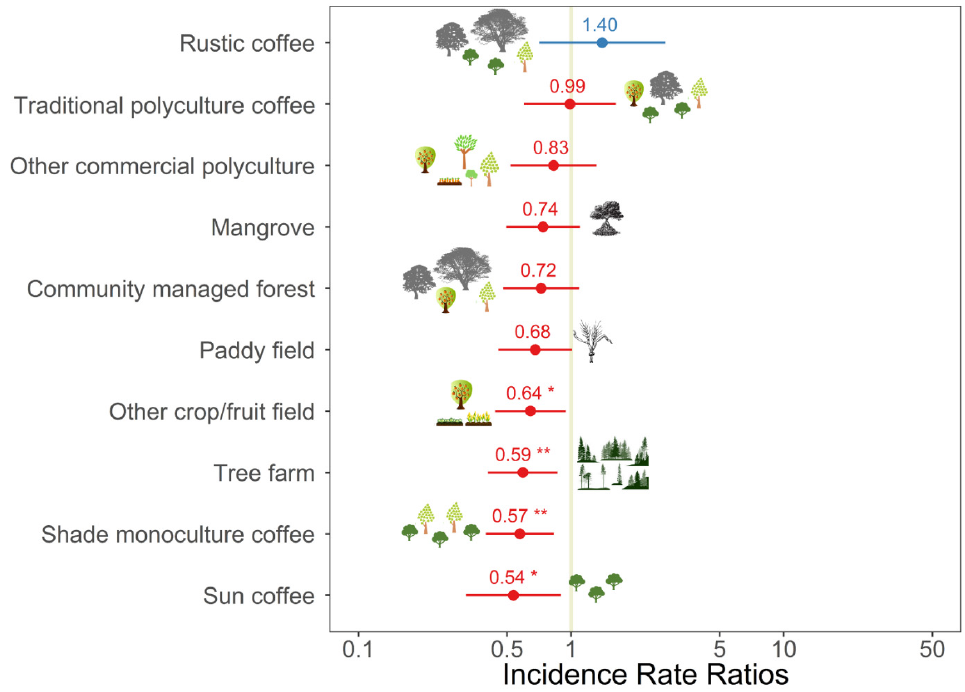
Figure 3. Incidence rate ratios between the diversity of birds (Shannon Index) in commercial poly- culture coffee (reference category) and other habitats considered during the survey on 1228 plots in Java, Indonesia. Data are standardised beta values and 95% confidence intervals from a generalised additive model. A description of the habitats can be found in the methods. Other predictors included in the model can be found in Table 2. * p < 0.05; ** p < 0.01.